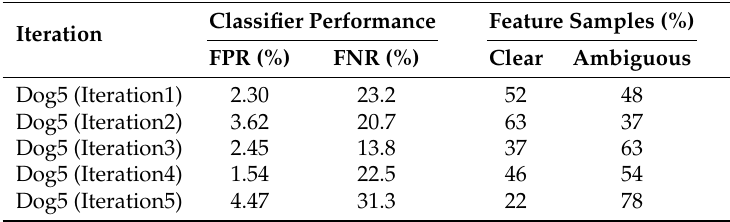
Table 12. Performance of the Support Vector Machine classifier in terms of False Positive Rate (FPR) and False Negative Rate (FNR) with Dog5 Pre-ictal dataset using set t feature set.